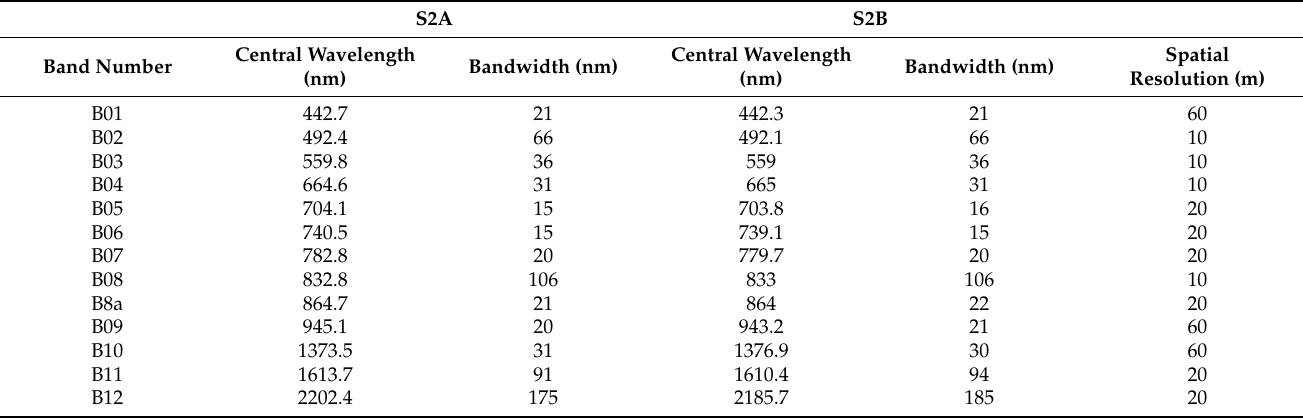
Table 4. Spectral band characteristics for Sentinel-2A and